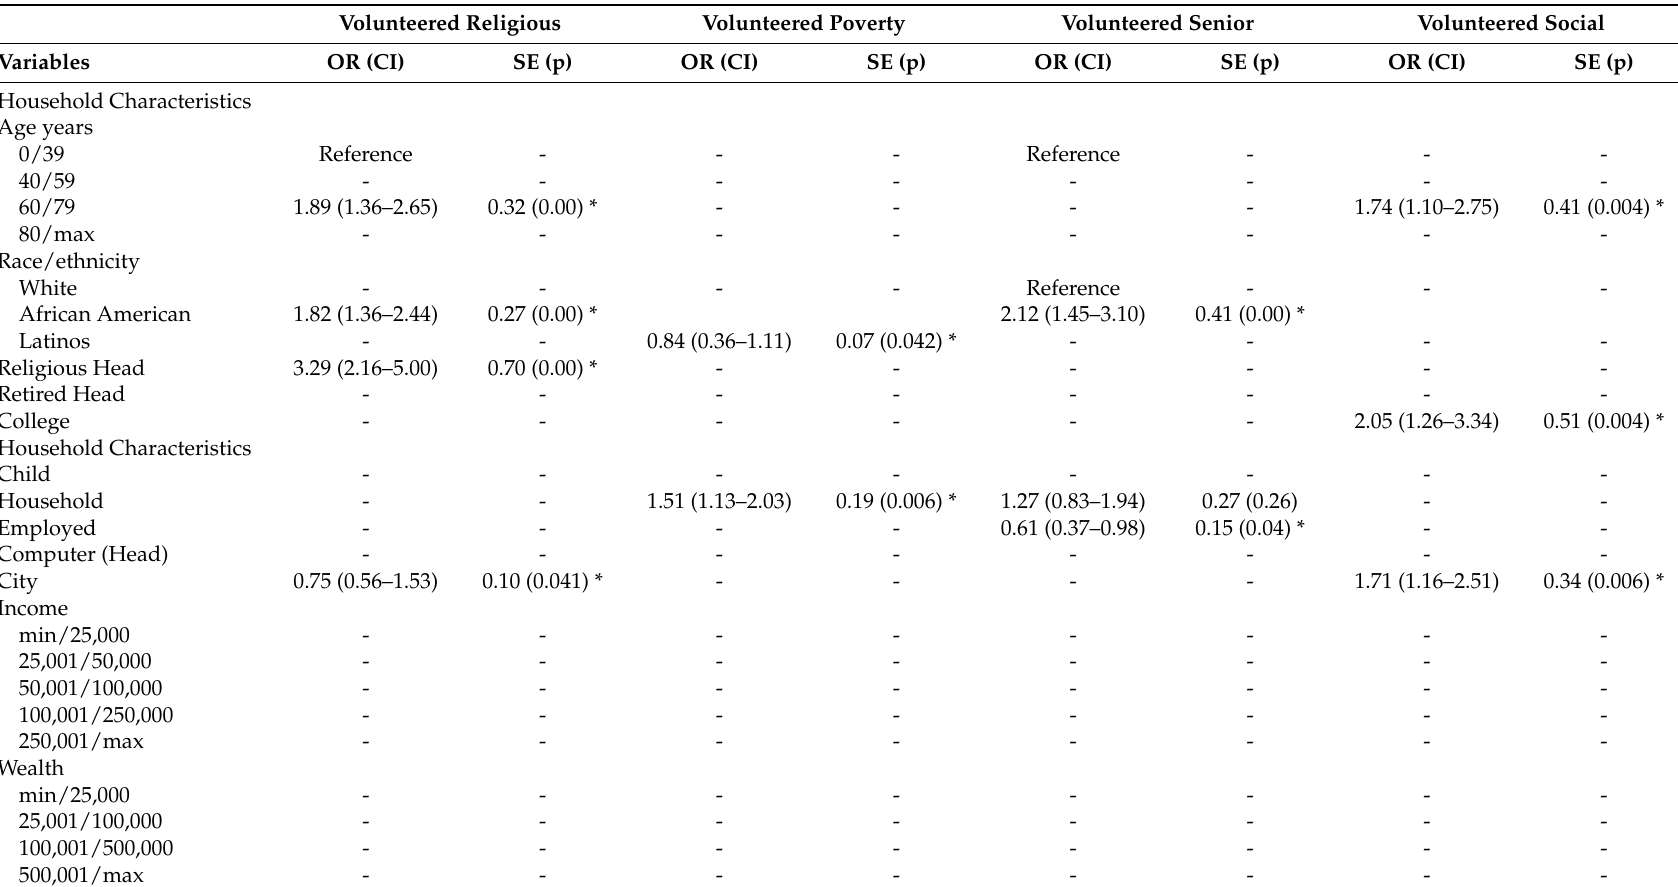
Table 5. A multivariate analysis predicting Head volunteering in organizations